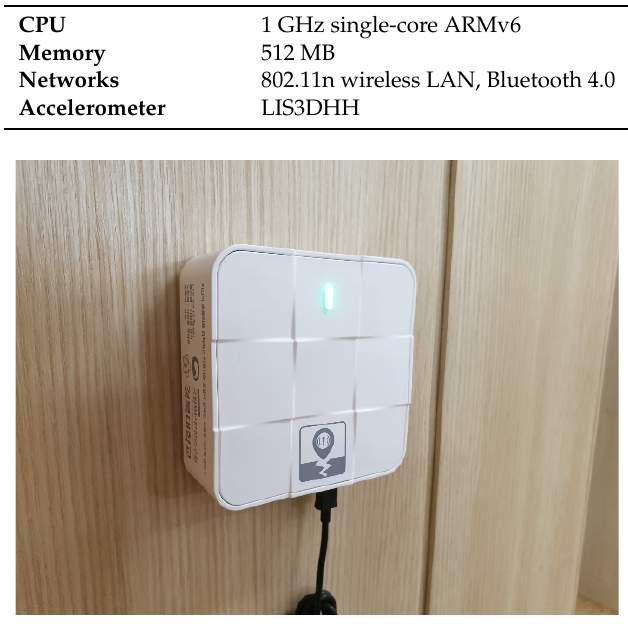
Figure 1. The developed earthquake alert device.